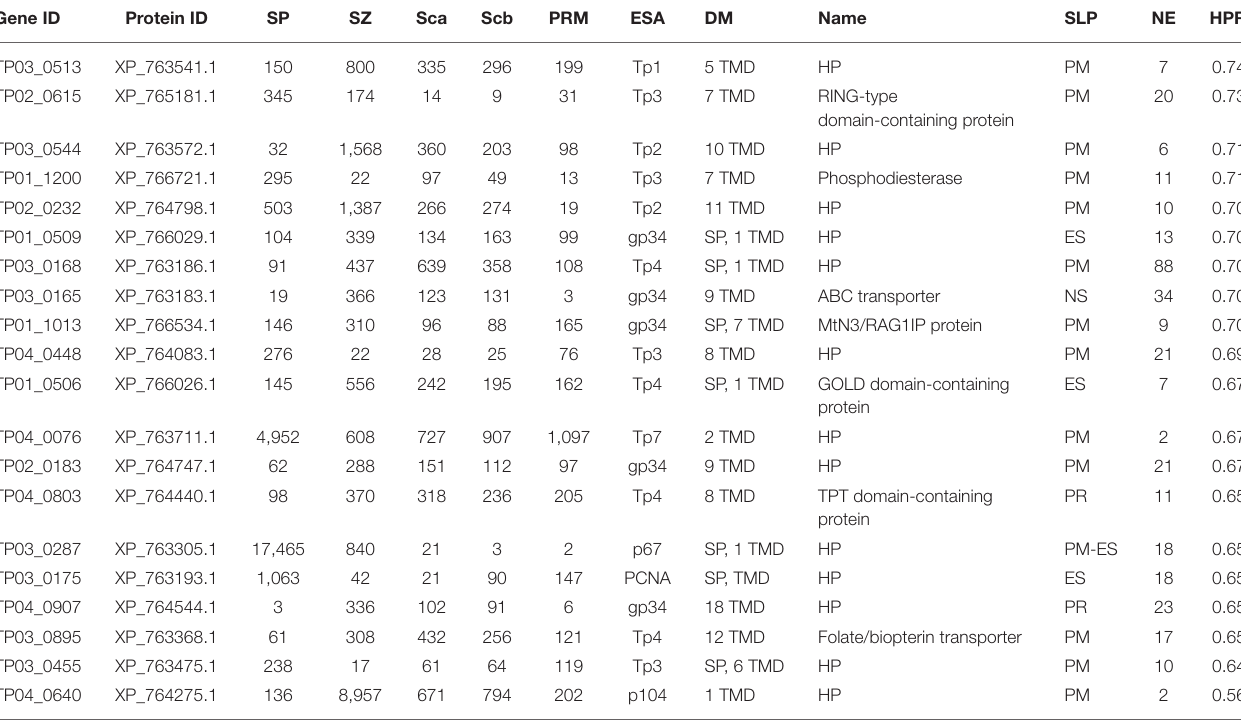
TABLE 5 | Top 20 T. parva surface proteins with high antibody epitope prediction values and with expression similar to known